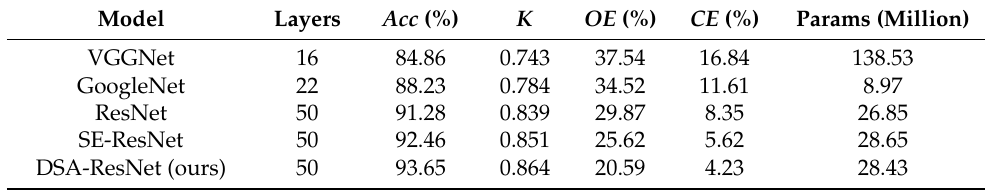
Table 3. Performances of different models on testing set using 60% training images.